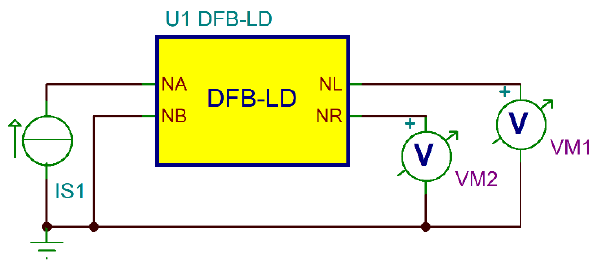
Figure 3. Test circuit of DFB-LD.